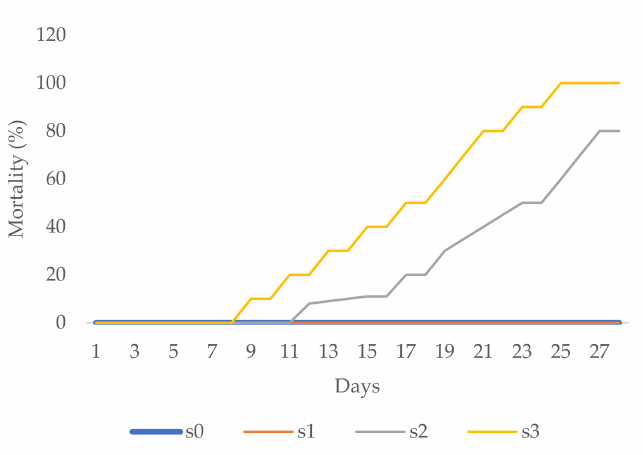
Figure 4. Zinnia mortality